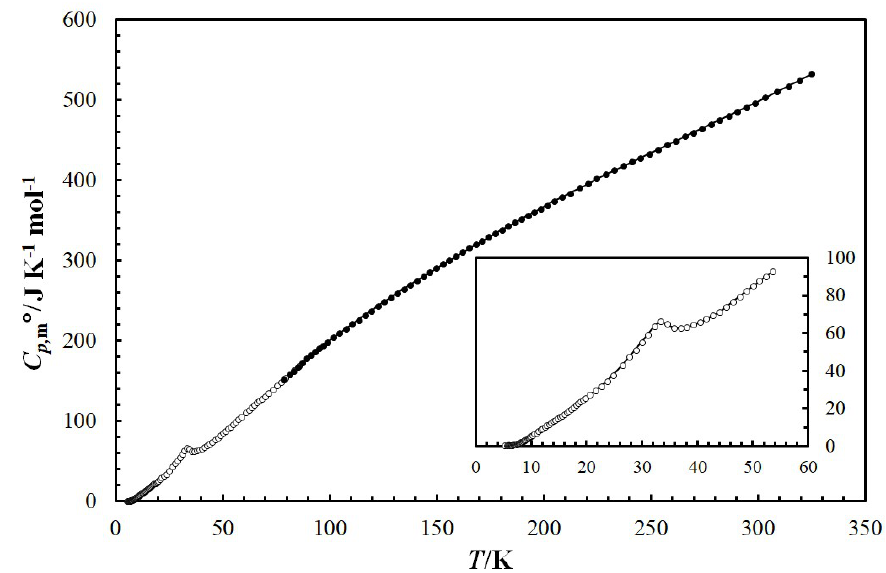
given with a 0.95 level of confidence (k ≈ 2).